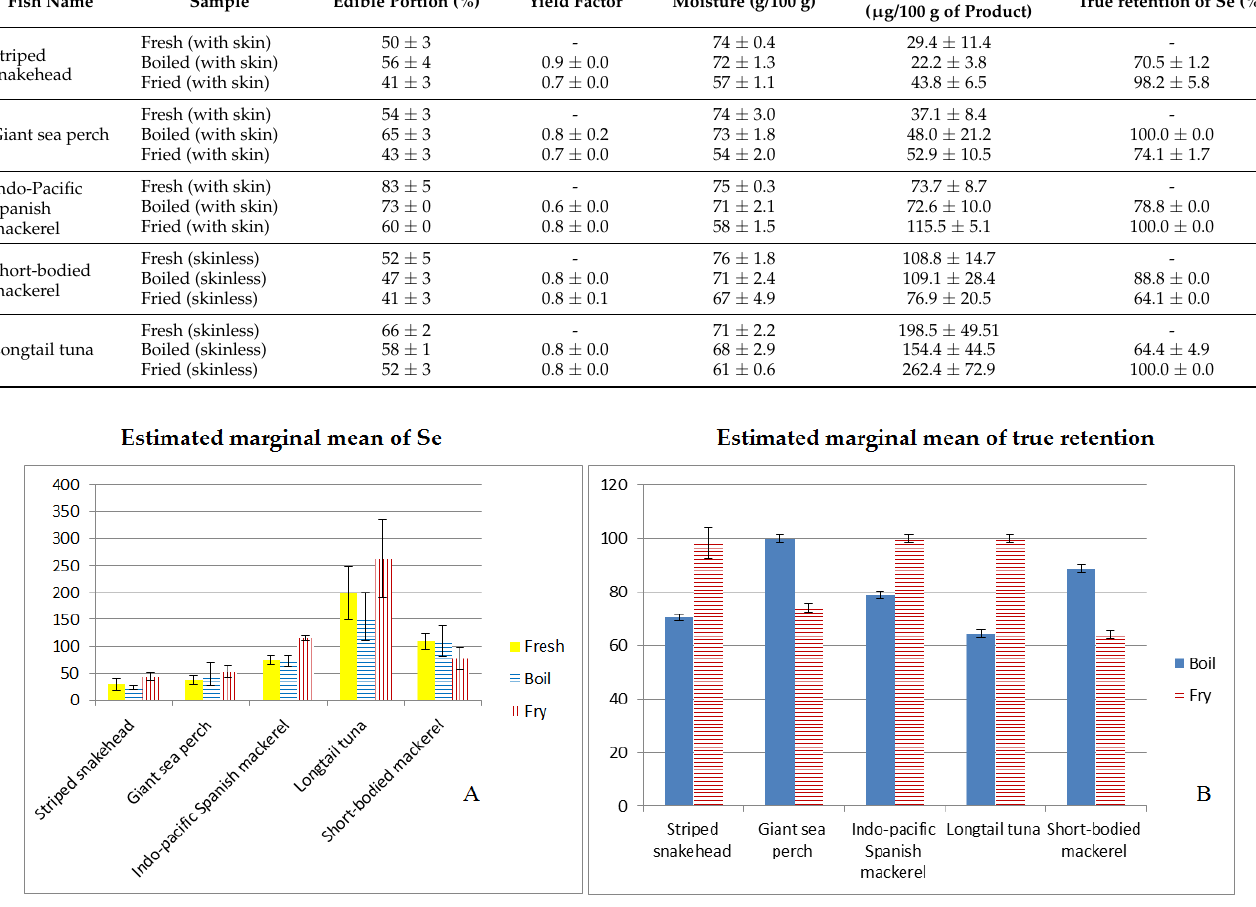
Figure 1. The combined effects of several fish species and cooking methods on Se concentration; y-axis is µg/100 g of product ( A ) and percentage of true retention; y-axis is means of percentage ( B ). Table 4. Data on estimated marginal means of the interaction effects of several fish species and cooking methods on Se content and true retention of Se ( n =